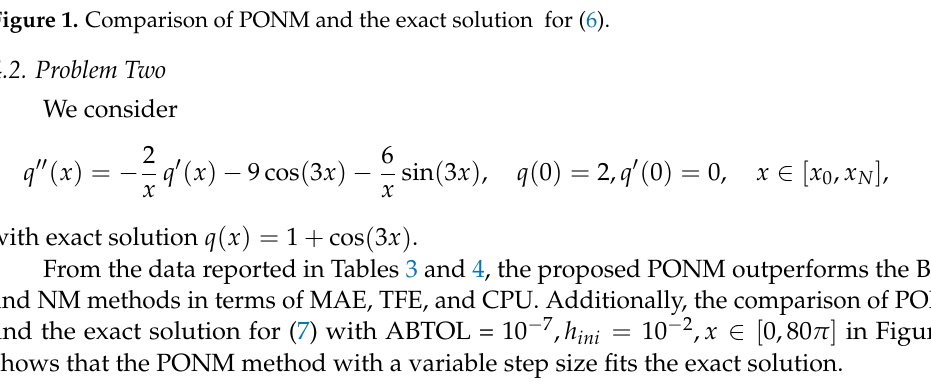
Figure 1. Comparison of PONM and the exact solution for